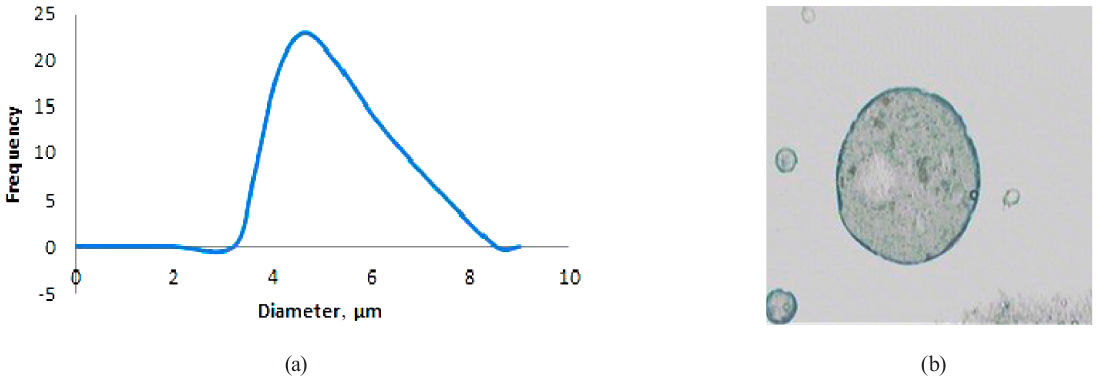
Figure 1 Initial droplet size distribution of emulsion (a), and optical microscopy image (400×) and surface morphology of EBCE microcapsules